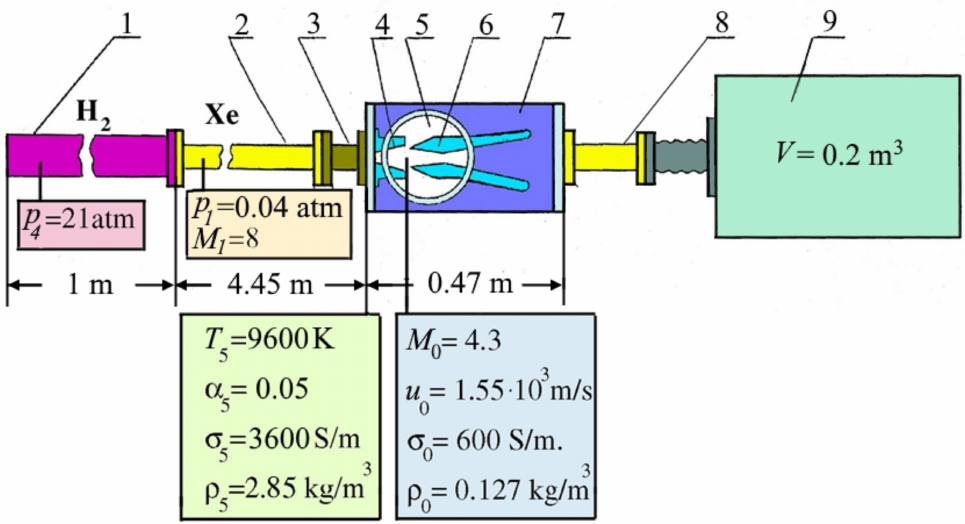
Figure 1. Scheme of the experimental setup. 1—high pressure chamber; 2—low pressure chamber; 3—diagnostic section; 4—accelerating nozzle; 5—optical window; 6—diffuser model; 7—vacuum working chamber; 8—outlet pipe with bellows; 9—damper